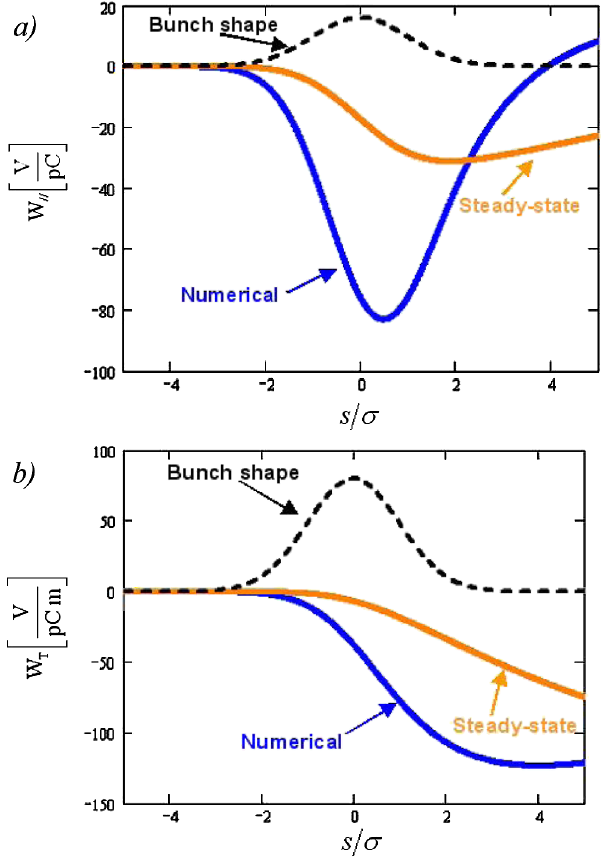
FIG. 12. Comparison of transient (blue solid) and steady state (orange solid) wake potentials.